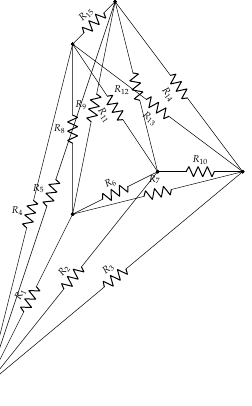
Figure 14. A multi-connected resistive grid from Figure